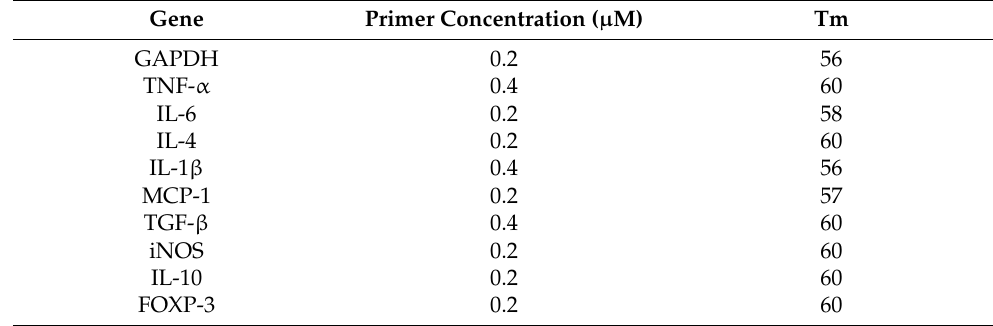
Table A1. Optimum conditions for the quantitative real-time PCR of different